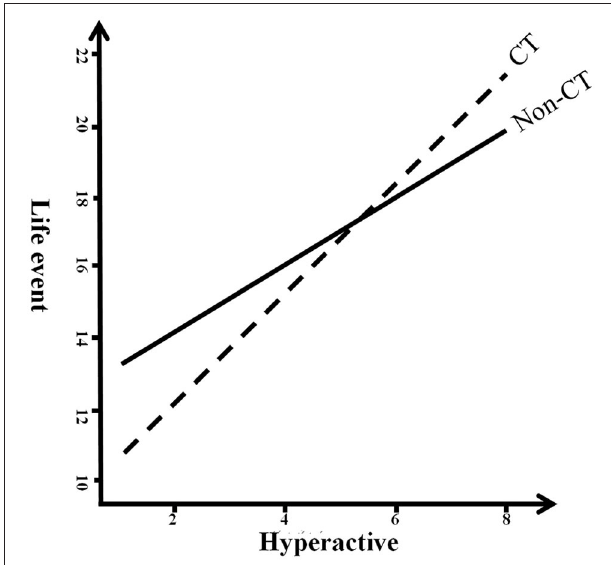
FIGURE 2 | Childhood trauma moderated the relationship between hyperactivity and life events in moderation mediation analysis. CT, Childhood